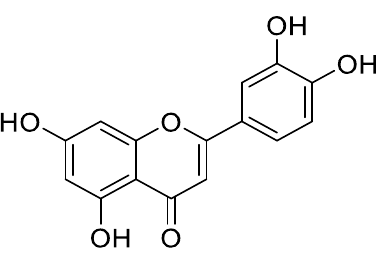
Figure 5. Chemical structure of luteolin. Molecules 2020 , 25 , x FOR PEER REVIEW